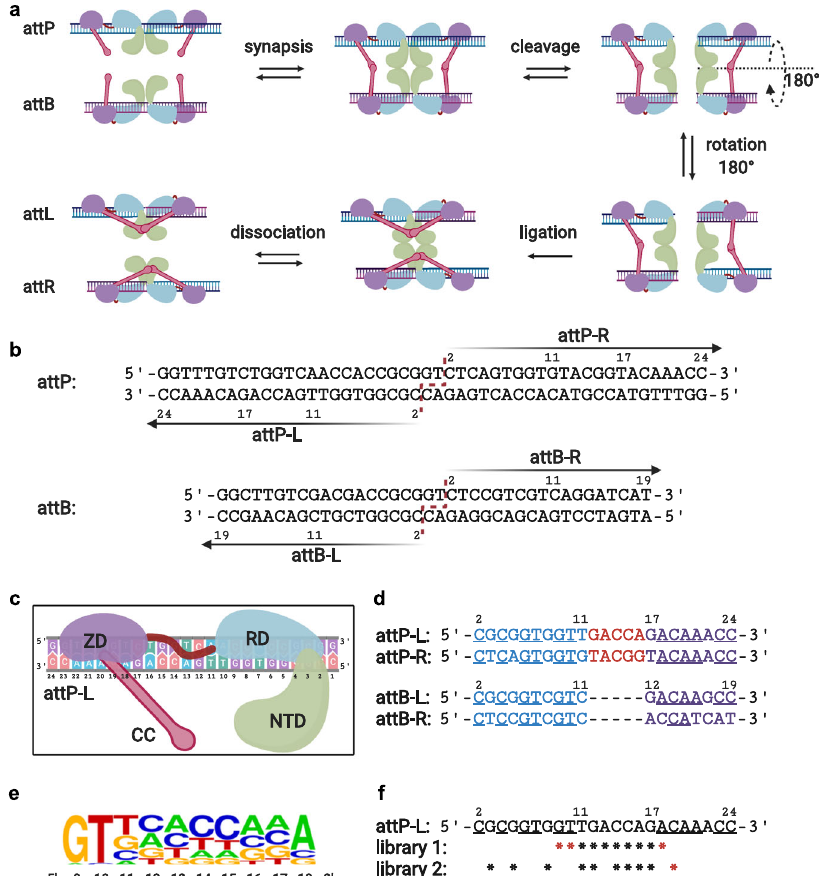
Fig. 1 Bxb1 attP-L DNA library design. a DNA inversion mediated by Bxb1 recombinase. Attachment sites attP and attB are bound by Bxb1 dimers, followed by synapsis through intermolecular binding of coiled-coil motifs (CC, pink). DNA sequences are then cleaved in the middle by the recombinase domain and rotated 180°. The resulting sticky ends, which are complementary, are ligated. After rotation, Bxb1 forms a more stable conformation, with CC motifs interacting within the same Bxb1 dimer on a given DNA sequence. Finally, Bxb1 dissociates from the two newly generated attachment sites, attL and attR, and the intervening DNA sequence is inverted. b DNA sequences of Bxb1 attP and attB sites. Cleavage happens at the central bases GT in both (red dashed line). Both attP and attB have two quasi-palindromic half sites attP-L/attP-R and attB-L/attB-R (also referred to as attP/attP ’ and attB/attB ’ half-sites). c In addition to the coiled-coil domain (CC, pink), a Bxb1 monomer includes the N-terminal domain (NTD, green), recombinase domain (RD, blue), and zinc ribbon domain (ZD, purple). A linker (red) connects RD and ZD and adopts different conformations when bound to attP or attB half-sites due to their differential lengths. d Comparison of attP and attB sites and their features. Four half-site sequences are aligned from center to end, with numbering from the 5'-terminus to the 3'-terminus. Underlined nucleotides indicate positions that are conserved across at least three half sites. Positions bound to RD or ZD are shown in blue or purple, respectively, and bases in red are aligned with the linker. e WebLogo of base frequency from position 9 to position 18 in library 1 after an E. coli- based selection. f Designed saturation mutagenesis libraries 1 and 2, where an asterisk represents a degenerate position in the library (with equal representation of bases A, C, G, and T at each such position; Supplementary Method 1 and Supplementary Table 4). Figures 1a, c were created with BioRender.com. Source data are provided as a Source Data fi